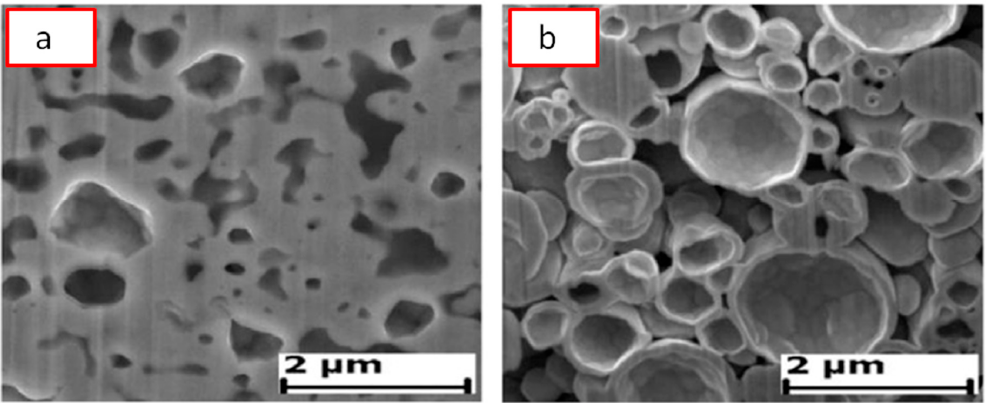
Figure 11. Cross-section of porous nickel obtained by pressureless SPS of hollow Ni particles obtained by spray solution combustion synthesis: ( a ) 500 °C, 30 min, porosity 70%; ( b ) 500 °C, 15 min, porosity 88%. Reprinted from Trusov et al. [22], Copyright (2018), with permission from